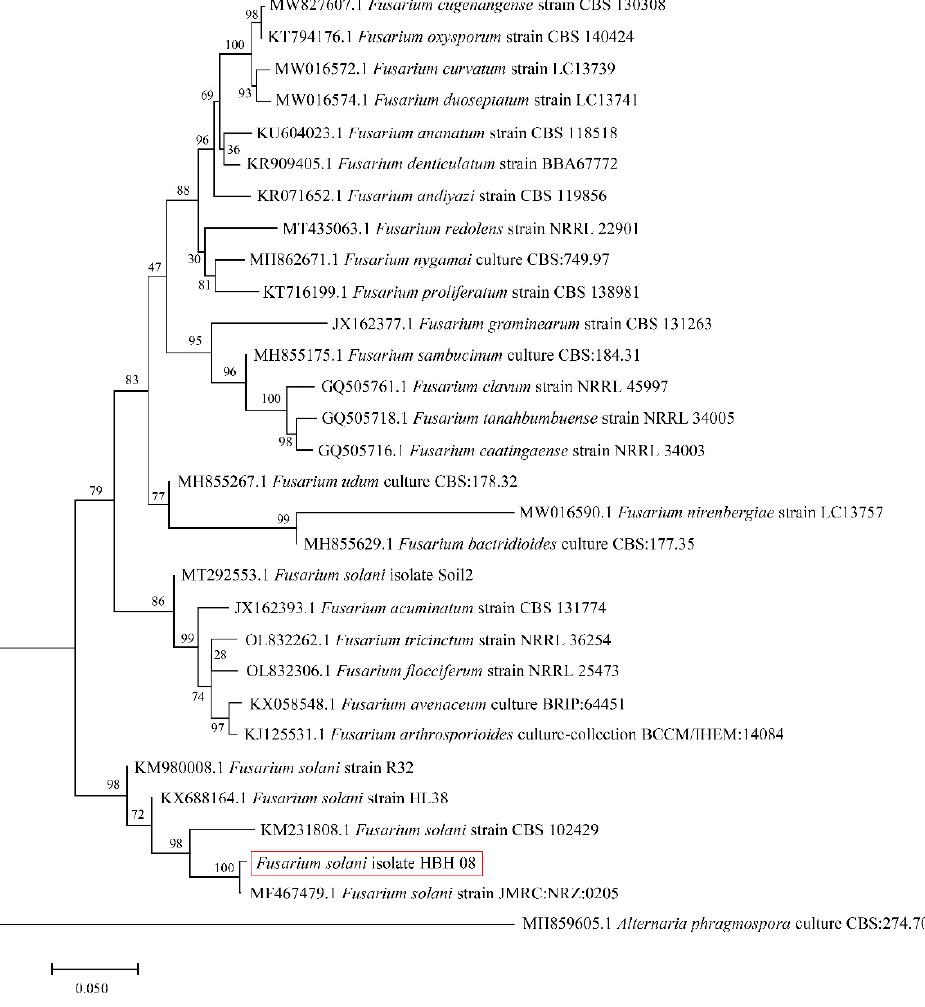
Figure 3. Phylogenetic tree constructed from the ITS sequence, TEF-1 α sequence, and RPB2 sequence of the isolated and identified fungal pathogen Fusarium solani isolate HBH 08. Data for other strains of different species were obtained from the NCBI GenBank. The developmental tree is drawn to scale, with branch lengths at the same evolutionary distances as the phylogenetic tree, and the marker lengths in the lower left corner are evolutionary distances. Table 3. Chemical components in the root exudates of A. fistulosum